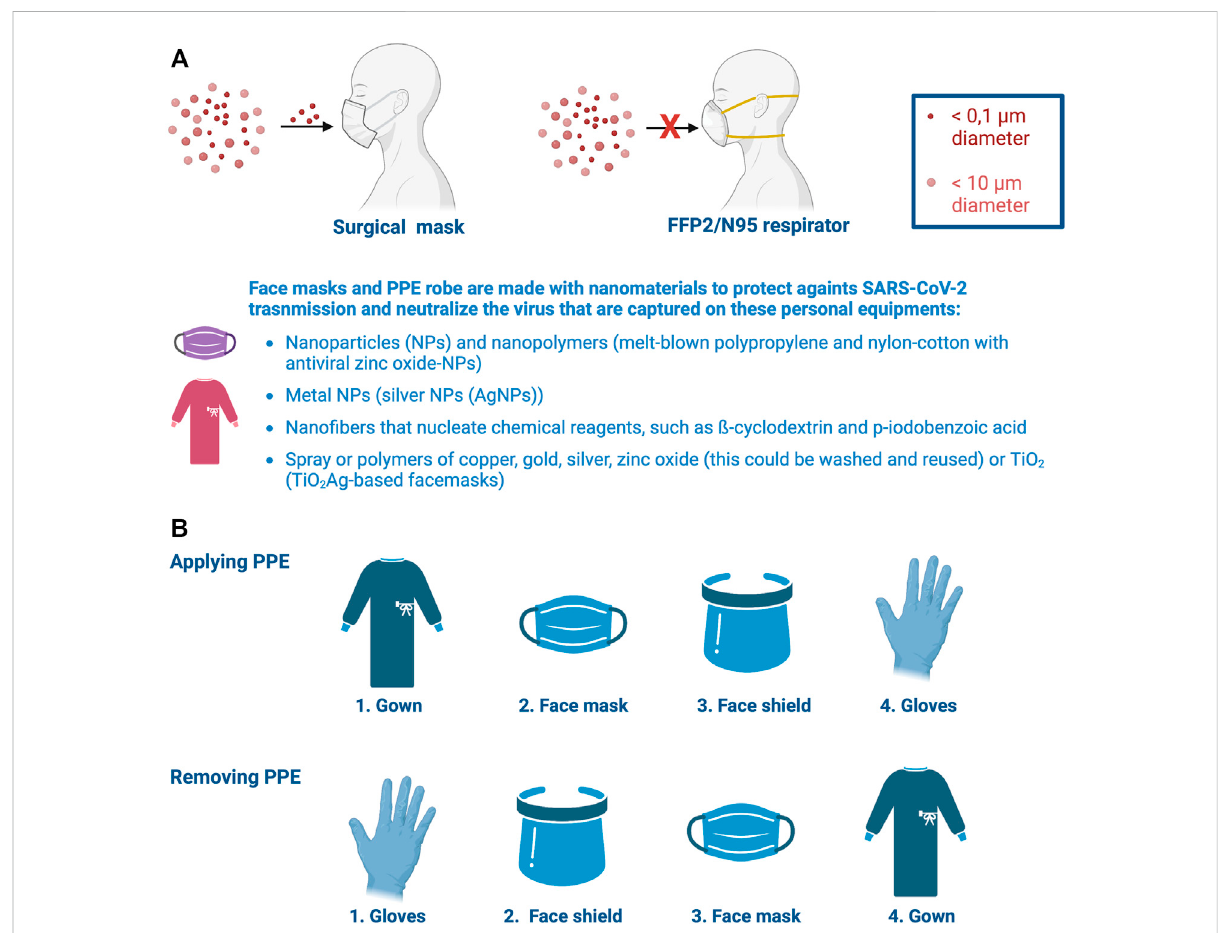
FIGURE 2 Nanomaterialsusedforprotectivepersonalequipment. (A) FFP2/NP95masksaretheappropriateprotectiverespiratorsagainstthisvirusmainly transmitted by aerosol compared with surgical masks. Face masks and PPE robes have been incorporated nanoreagents and nanomaterials to improve personal protection against SARS-CoV-2 airborne infection and transmission to neutralize the virus in contact with these personal equipments. These nanomaterials are indicated in panel (A) . (B) Personal training and correct protocols for wearing (applying) and removing these PPEs from the body are critical to ensure right protection of health personnel against SARS-CoV-2 infection. Designs and templates are created with